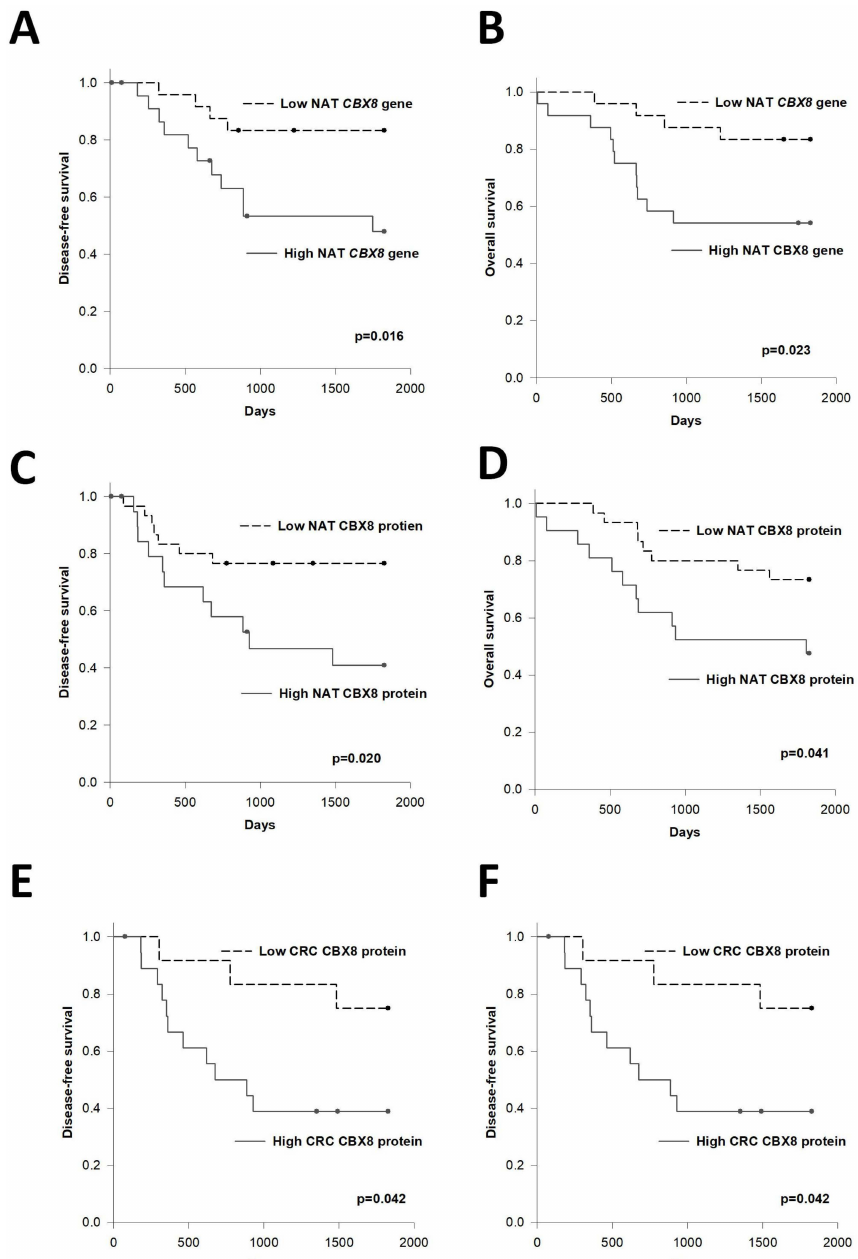
Figure 2. Correlation between CBX8 level and survival of CRC patients. ( A , B ) CRC patients with high NAT CBX8 gene levels, compared to those with low NAT CBX8 levels, have a significantly poorer ( A ) disease-free survival and ( B ) overall survival. ( C , D ) CRC patients with high NAT CBX8 protein levels, compared to those with low NAT CBX8 levels, have a significantly poorer ( C ) disease- free survival and ( D ) overall survival. ( E , F ) CRC patients with high CRC CBX8 protein levels, compared to those with low CRC CBX8 levels, have a significantly poorer ( E ) disease-free survival and ( F ) overall